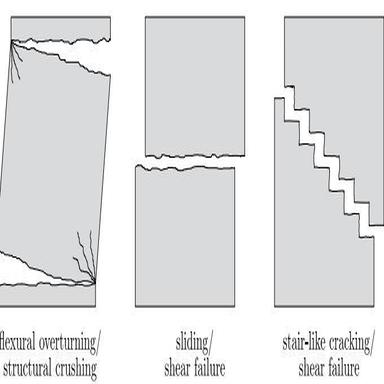
Typical shear failure modes of masonry structures.